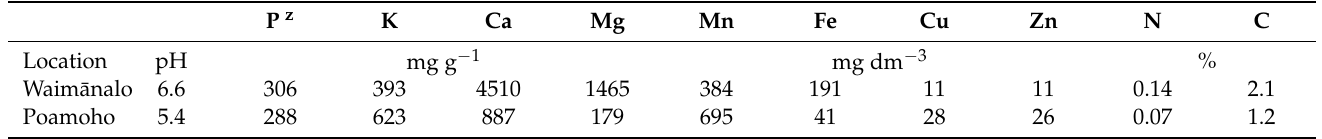
Table 1. Soil analyses from field trials at two locations in O’ahu, Hawai’i.